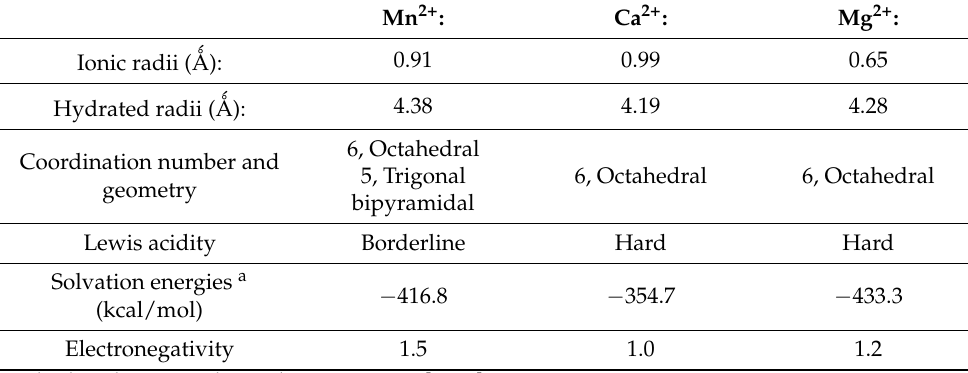
Table 9. Tabulated chemical properties of Ca, Mn and